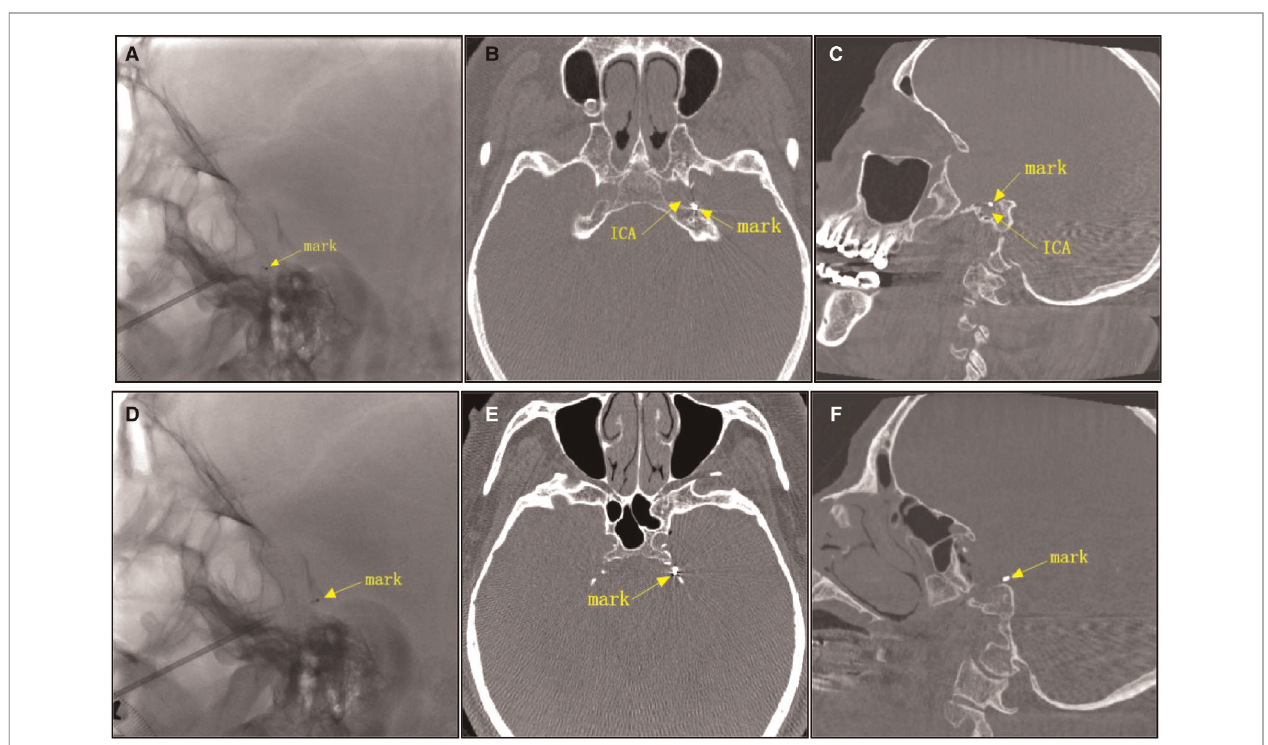
FIGURE 4 | A notable case.The yellow arrow shows the distal mark of the